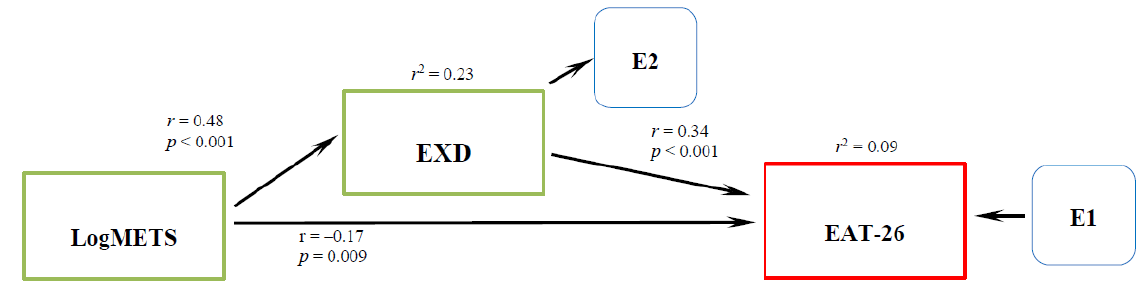
Figure 3. Final Path analysis of the relationship between LogMETS, EXD and EAT-26 for females.